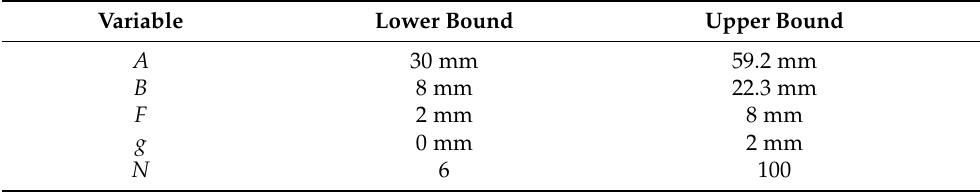
Table 2: Table 2. Ranges adopted for the design